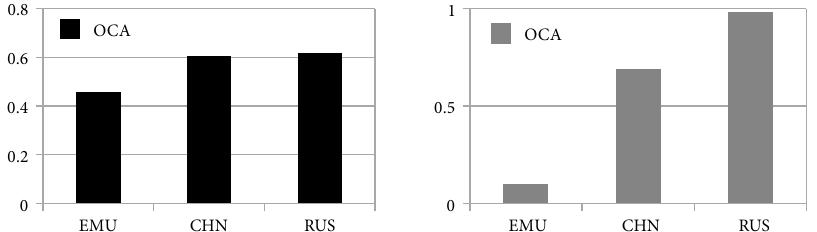
Figure 5. OCA indices based on unofficial (left) and official (right) exchange rates (source: own